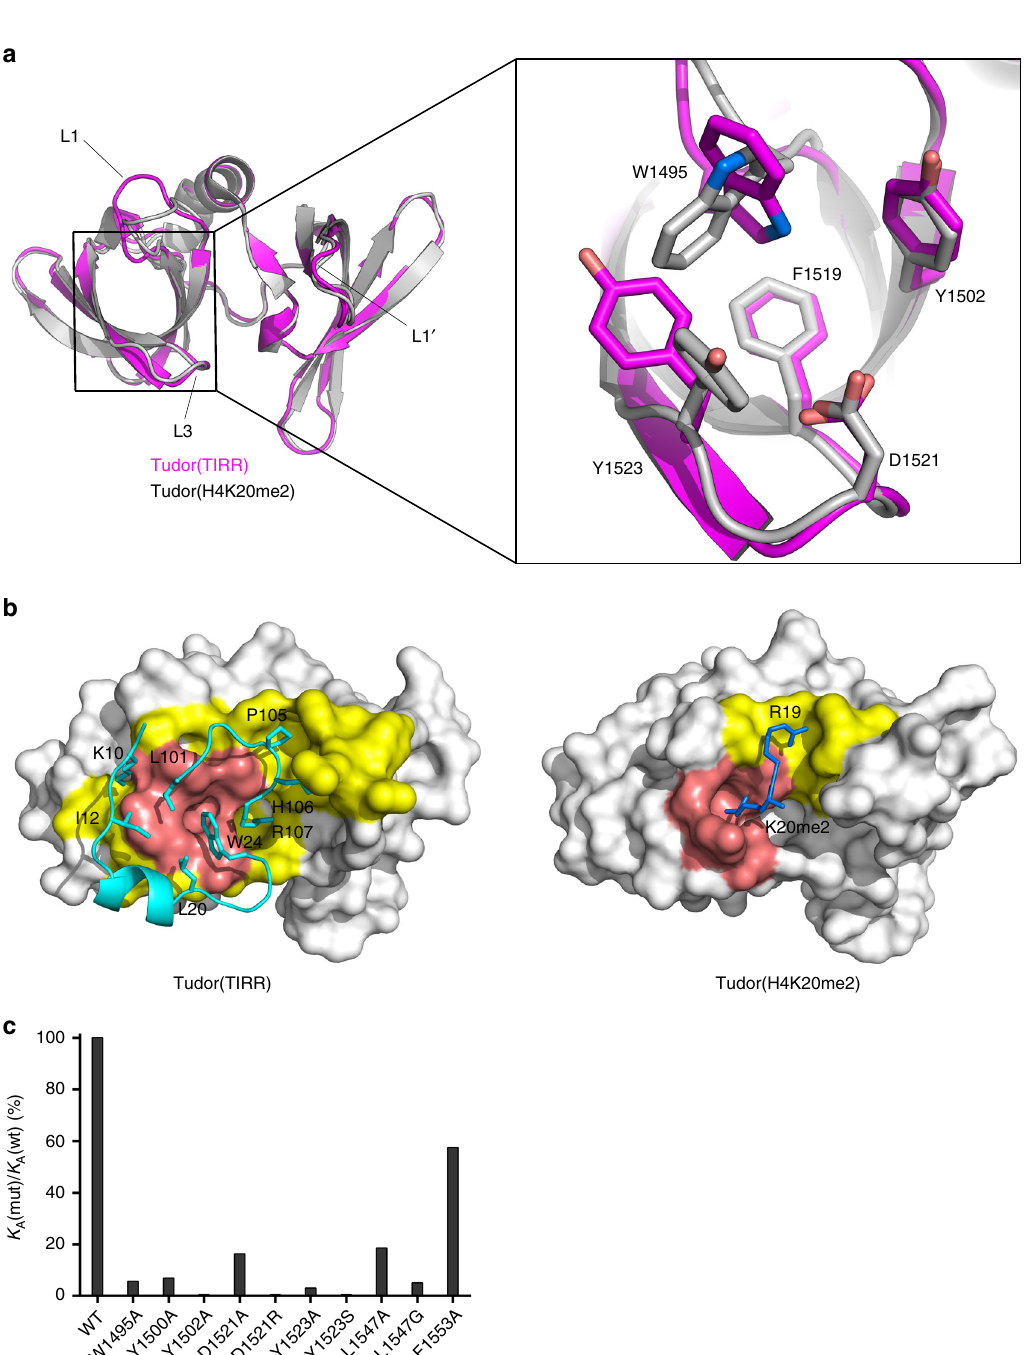
Fig. 3 Structure of the 53BP1 tandem Tudor domain in the complex of TIRR. a Structural comparison of 53BP1 Tudors in complex with TIRR (magenta) or H4K20me2 (gray, PDB 2IG0) (left) and close view of methylation-reading aromatic cages in superimposition (right). Highlighted are 53BP1 residues W1495, Y1523, D1521, Y1502, and F1519 forming the aromatic cage. b Surface representation of 53BP1 Tudor structures in TIRR-bound form (left) and H4K20me2-bound form (right). Residues of TIRR and histone H4K20me2 involved in Tudor interaction are displayed and colored in cyan and blue, respectively. Highlighted are 53BP1 residues forming the aromatic cage (salmon), and other 53BP1 residues involved in TIRR and H4K20me2 binding (yellow). c Effect of 53BP1 Tudor mutations on TIRR binding analyzed by